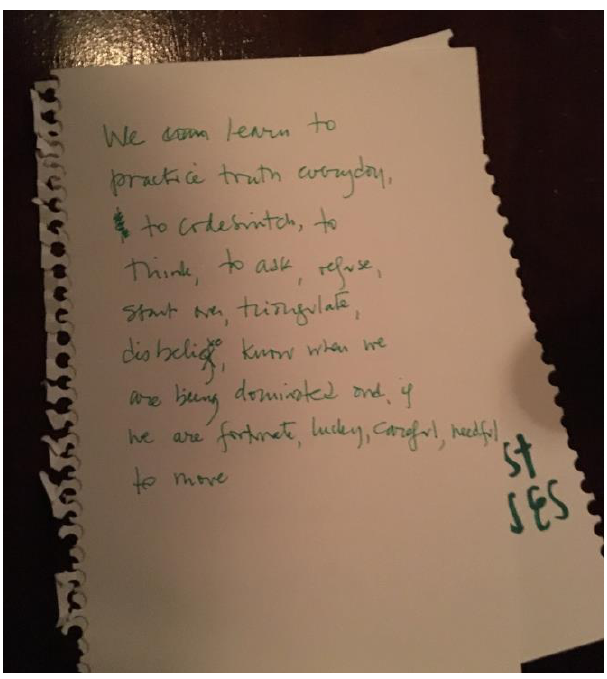
FIGURE 2: FROM TORONTO